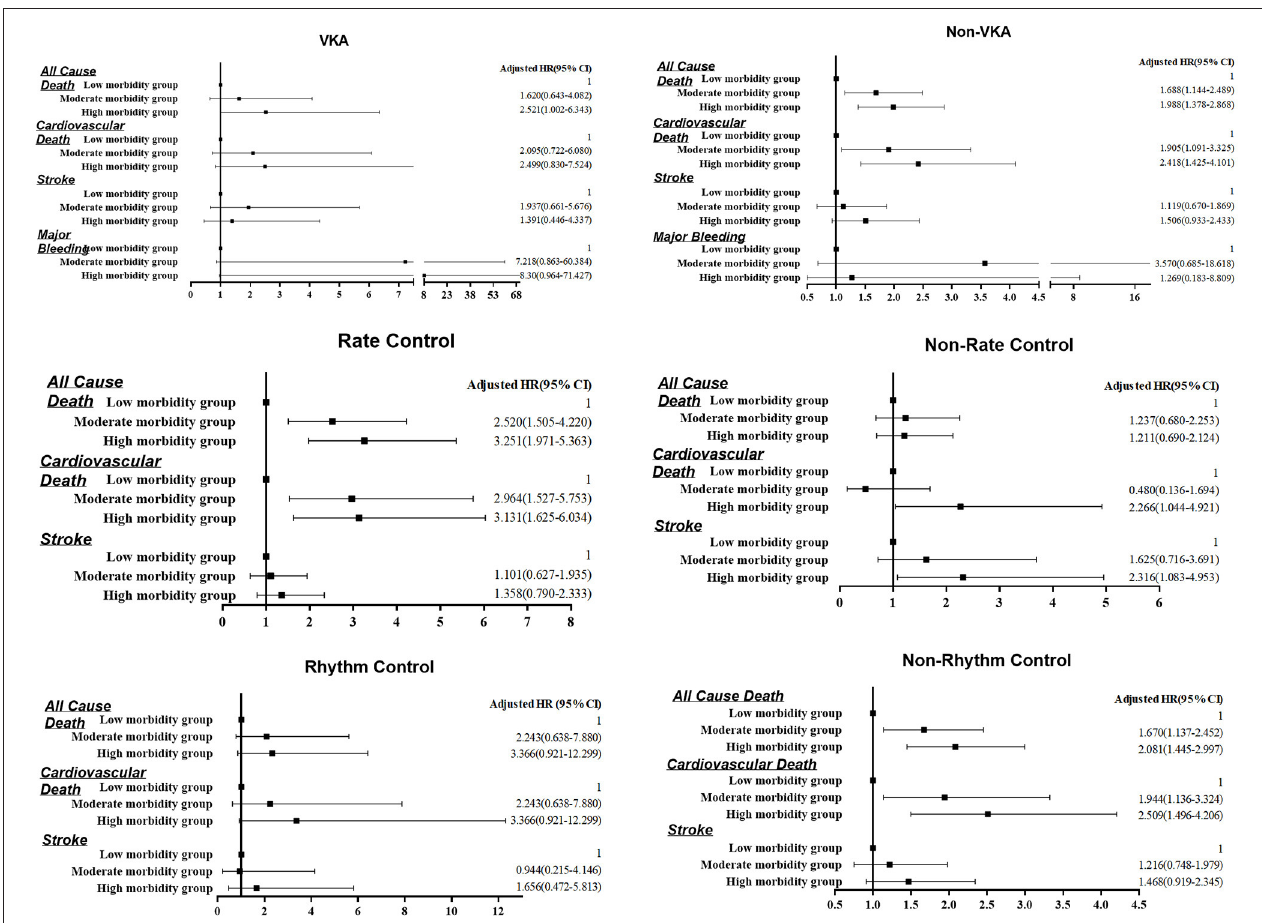
FIGURE 4 | Multivariate Cox proportional models of predictors for all-cause death, cardiovascular death, stroke, and major bleeding by morbidity categories and different treatment strategies.